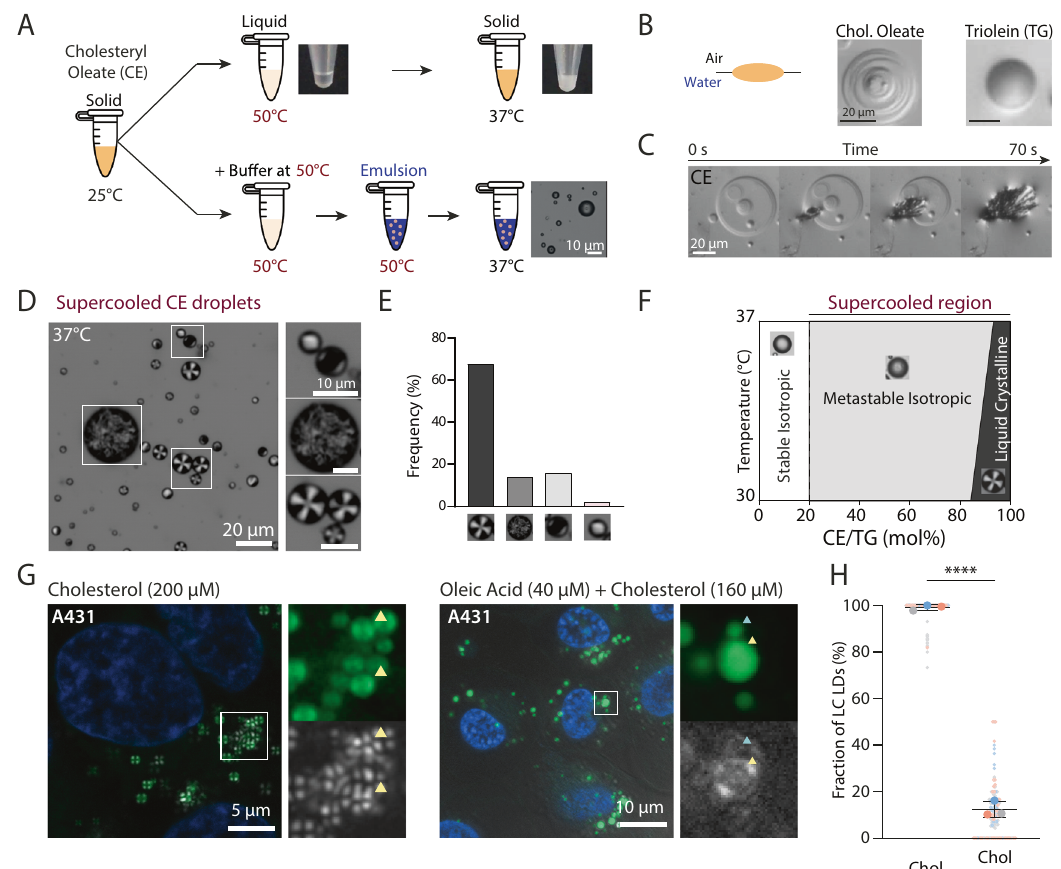
Fig. 1 | CE can form supercooled droplets in vitro. A Top: Schematic repre- sentationofbulkCE(here,cholesteryloleate)uponheatingfrom25°Cto50°Cand cooling down to 37°C. Bulk CE lique fi ed when heated above its melting point and solidi fi ed upon cooling to 37°C. Bottom: Schematic representation of CE emulsi- fi cation protocol. CE was heated above its melting point and HKM buffer was added at 50°C. The mixture wasemulsi fi ed by vortexing and sonicating,and then imagedunderconfocalmicroscopy.Thedropletsappearedtobe(meta)stableand thussupercooled. B CEandTG(here,triolein)emulsionswereimagedatthewater- air interface in bright fi eld. Left: Schematic representation of an oil droplet spreadingatthewater-airinterface.Middle:imageofaCEdropletspreadingatthe water-air interface. Some droplets revealed concentric rings. Right: Image of a TG droplet spreading. No concentric rings were observed. C Live imaging of the crystallizationofaCEdropletuponmeetingwithanucleationseed. D Supercooled CE droplets were imaged using polarized light microscopy on a temperature-